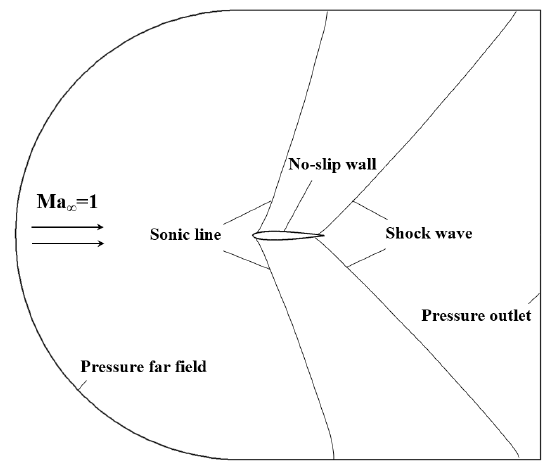
Figure 3. NACA0012 airfoil computed